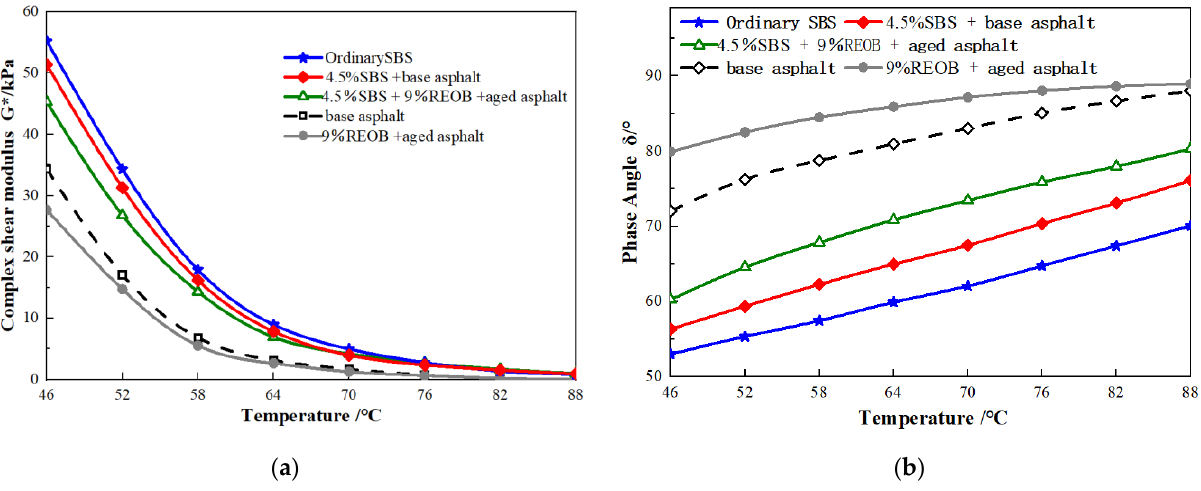
Figure 3. ( a ) Variation of G* with temperature; ( b ) Variation of δ with temperature Rutting Factor and Critical Temperature